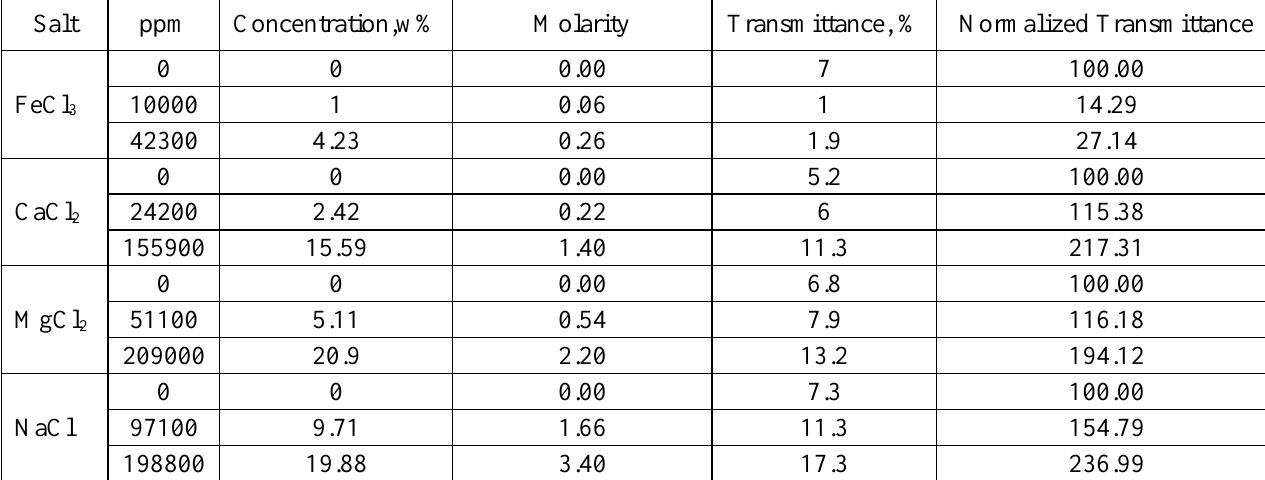
Table 4—Transmittance results of HPAM FR solution with different salts.